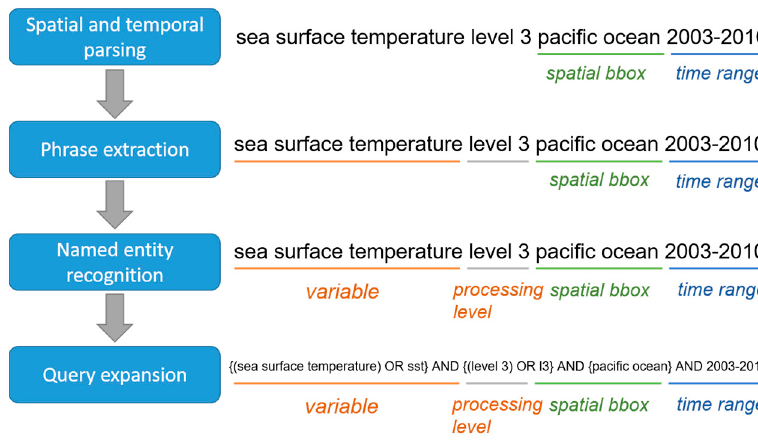
Figure 3. A conceptual framework for query understanding.